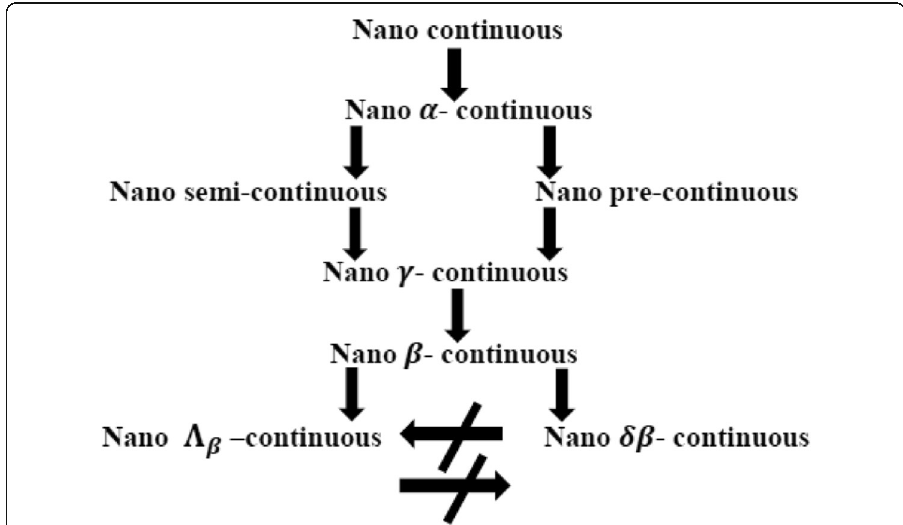
Fig. 4 The relationships between the different types of nano near continuous